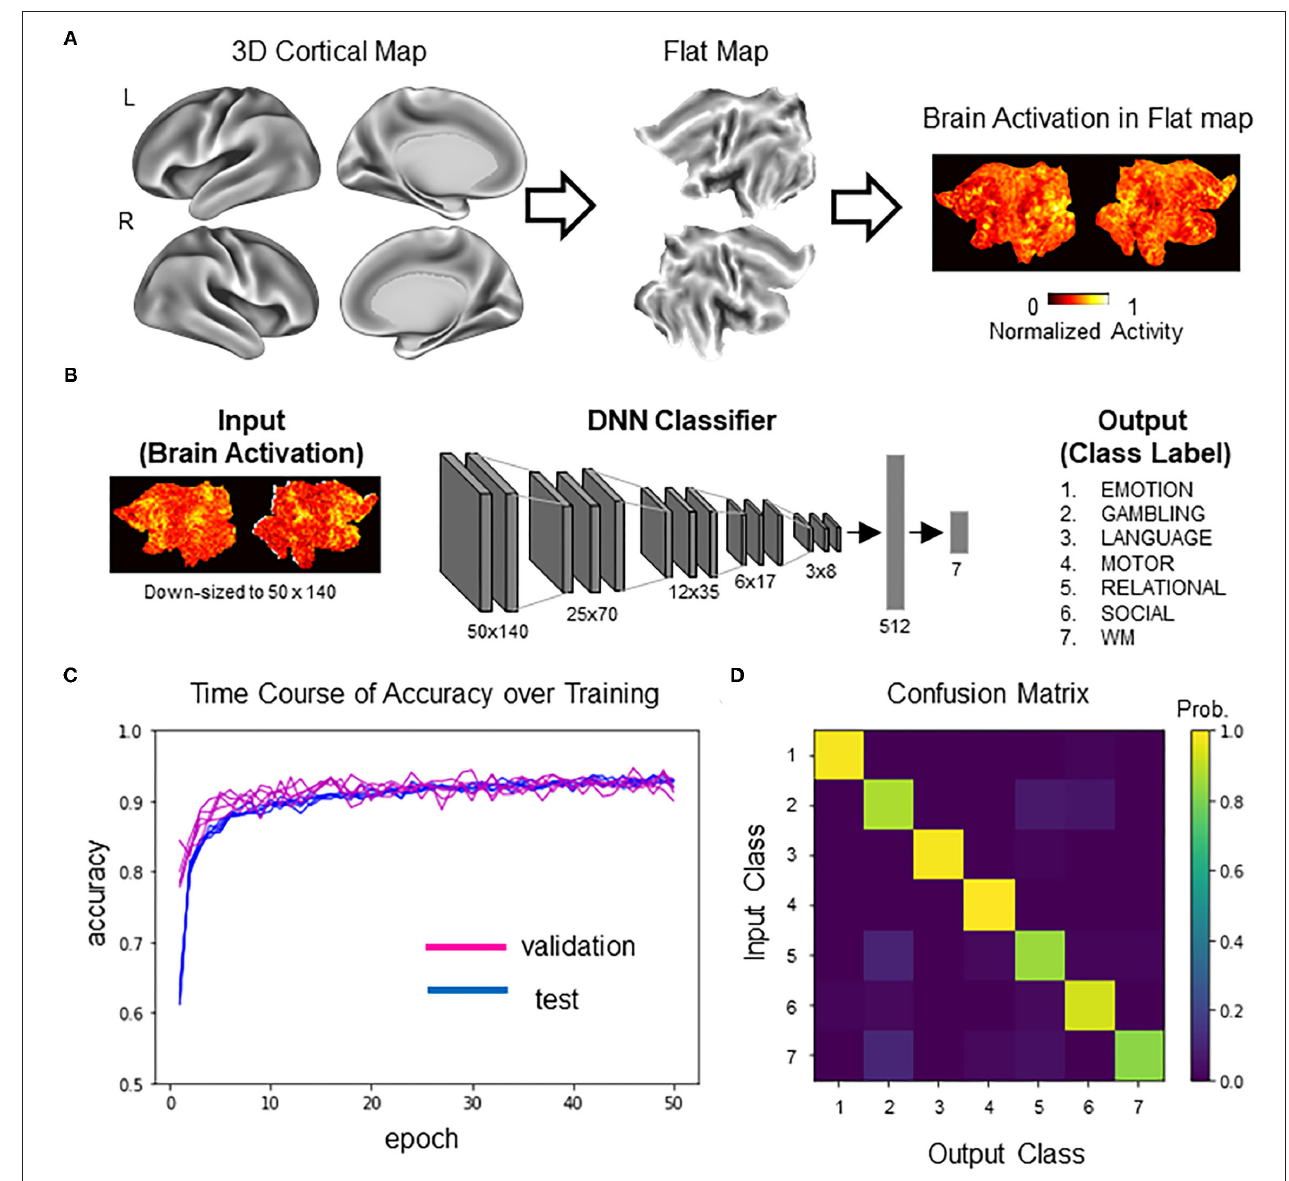
FIGURE 2 | DNN classifier for brain activity decoding. (A) Following the standard procedure developed by HCP (Glasser et al., 2016), neocortex in the two hemispheres was mapped to two cortical sheets. Each neocortical activity image was mapped to the two sheets, which was then input to the DNN classifier (for details, see Tsumura et al., 2021). (B) Model architecture of the DNN classifier. The input was a picture containing two sheets of cortical activations. The picture was downsampled for later processing by the generative neural network. The DNN classifier was a deep convolutional network similar to the one described in our previous study (Tsumura et al., 2021). The output of the DNN classifier was one-hot vectors representing seven behavioral tasks in the HCP dataset. (C) Training history of the transfer learning. Test accuracy (blue) and validation accuracy (magenta) are shown for five replicates. Note that the chance level is 14.3% (1/7). (D) Profile of the classifier’s decision (confusion matrix) in the validation